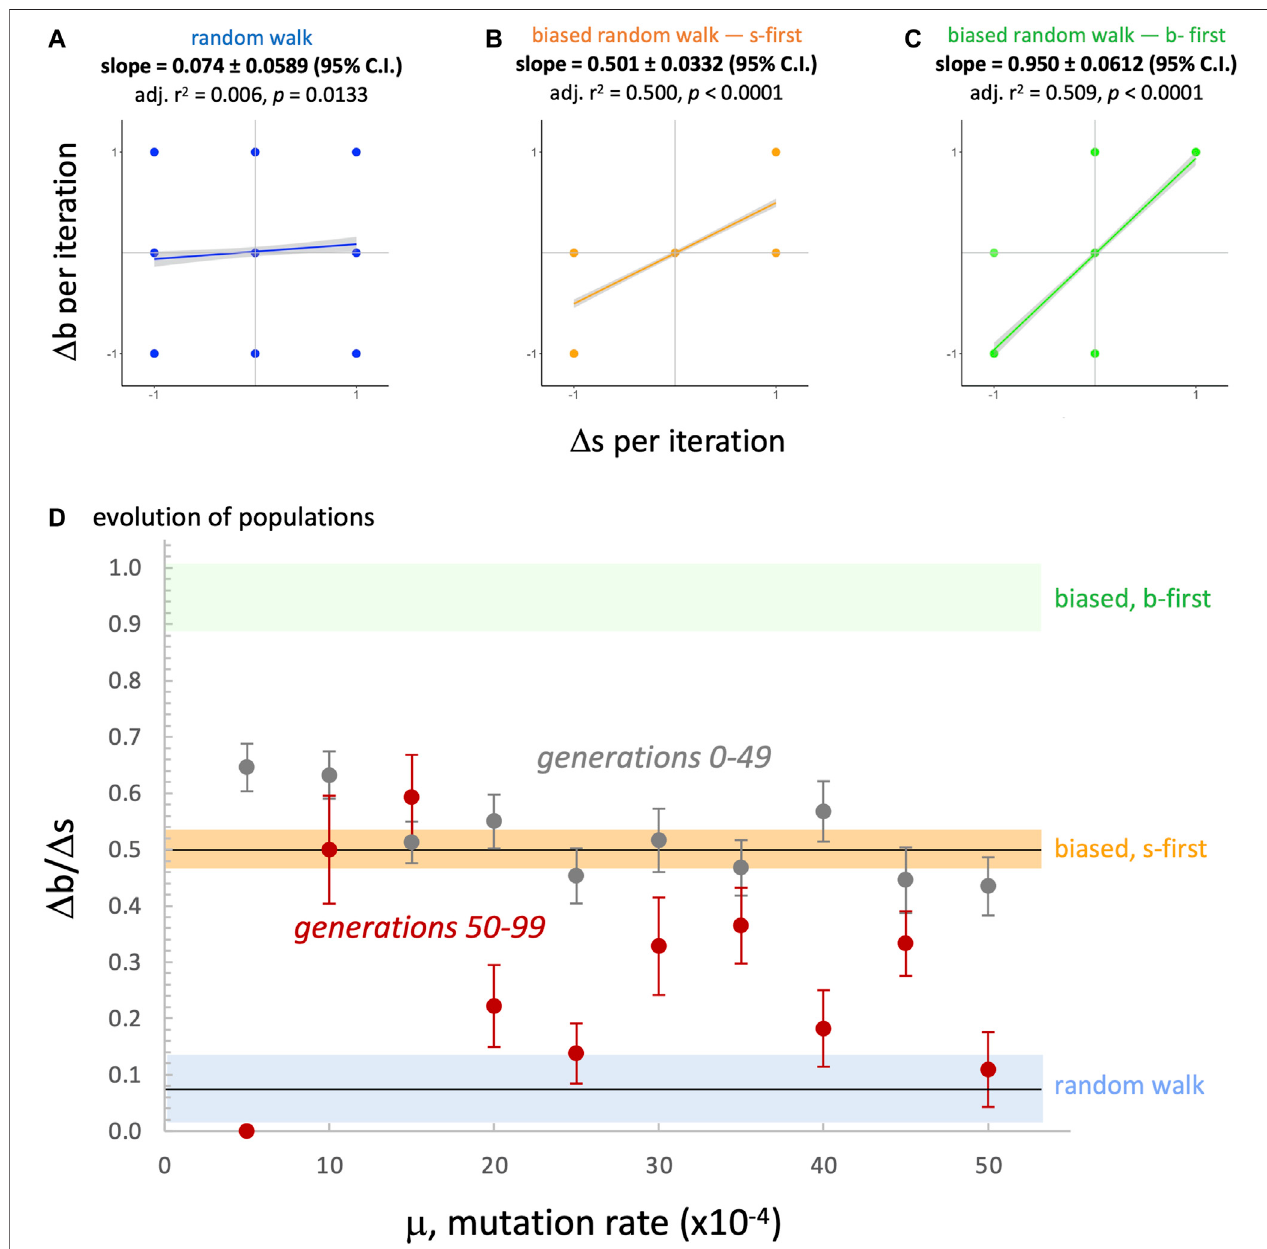
FIGURE 13 | Random morphospace walk analysis: developmental bias in evolution? From the simpli fi ed set of steps available for a random walk and developmentallybiasedrandomwalks,weexpectthreedifferentrelationshipsbetweentherateofchangeof b and s (A – C) .Dataforthesemodelsiscalculatedfromnine runsofeach,with99generations ( n (cid:1) 891 ) .Inevolvingpopulations (D) ,evidenceforapossibledevelopmentalbiasinevolutionisseenintheoverlapof95%con fi dence intervals (error bars) withthe biased, s- fi rst random walkmodel (orange bar, vertical range (cid:1) 95% con fi dence interval). Formost levels ofmutation rate, the evolved populations overlap for the fi rst 50 generations but not that last 50. For those later generations, three levels of mutation overlap with the random walk (blue bar, vertical range (cid:1) 95% con fi dence interval).